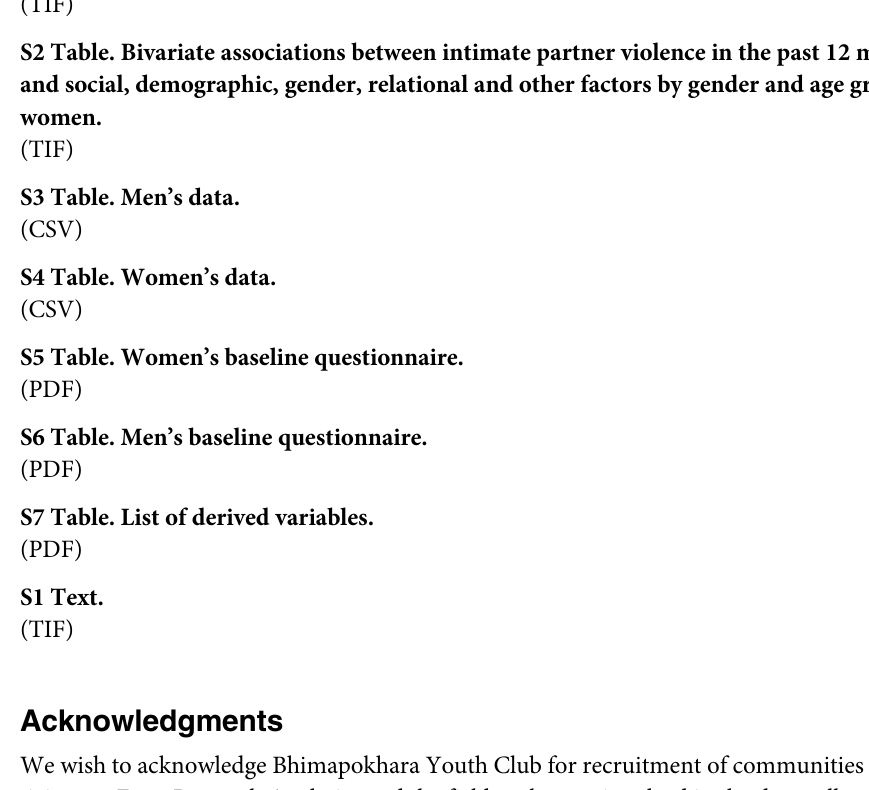
S5 Table. Women’s baseline questionnaire. S6 Table. Men’s baseline questionnaire. S7 Table. List of derived